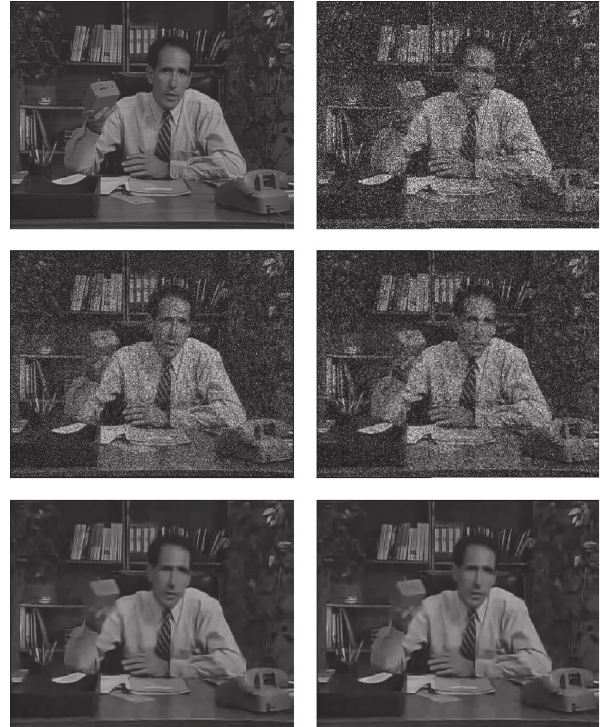
Figure 2: Visual comparison of different algorithms for frame 5 of Salesman sequence. From left to right and from top to bottom: original frame, noisy frame ( 𝜎 𝑛 = 40 ), result of [18] algorithm, result of [19] algorithm, result of [13] algorithm, and result of the proposed algorithm.